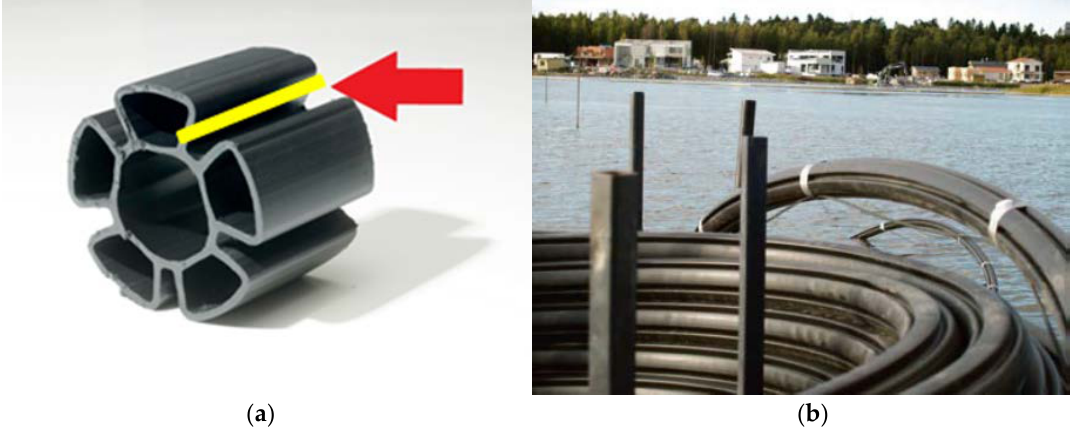
Figure 1. ( a ) Profile of the heat collector pipe and the location of an optical cable; ( b ) The assembling of heat collection pipes.